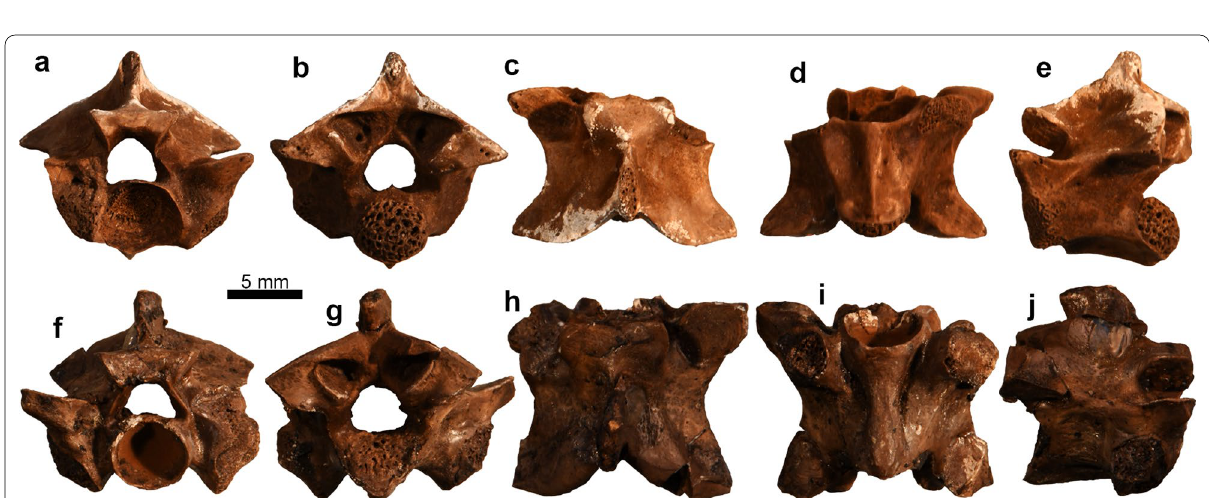
Fig. 67 Eoconstrictor cf. fischeri from quarry Cecilie I, Geiseltal: a – e mid-trunk vertebra (GMH Ce I-5835c-1929) in anterior ( a ), posterior ( b ), dorsal ( c ), ventral ( d ), and left posterolateral ( e ) views; f – j posterior trunk vertebra (GMH Ce I-5835h-1929) in anterior ( f ), posterior ( g ), dorsal ( h ), ventral ( i ), and right lateral ( j ) views [this specimen was originally figured by Kuhn (1939a:pl.